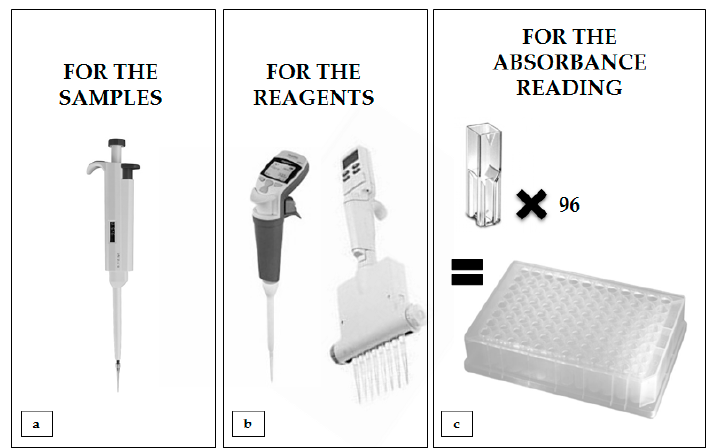
Figure 15. The use of appropriate tools significantly speeds up the biochemical analysis and absorbance reading: ( a ) when dispensing samples with biological material, it is worth using an automatic one-channel pipette with easily changeable tips; ( b ) for pipetting the same volume of the reagent many times, it is worth using an electronic (optionally multi-channel) automatic pipette (there is no need to change the tips until they come in contact with the biological material in the tube); ( c ) if we have a spectrophotometer reading of the absorbance from 96 well plates, we should use it in place of individual cuvettes.